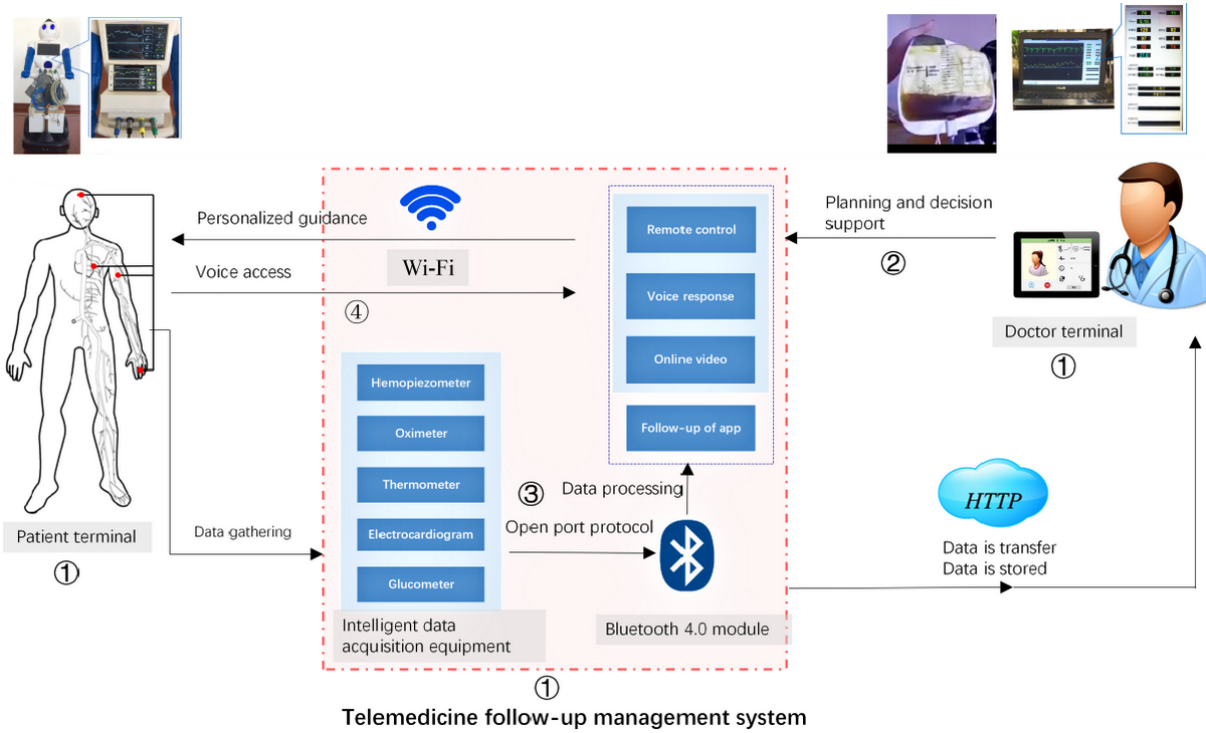
Figure 1. Schematic of the telemedicine follow-up management system. ① The telemedicine follow-up management system includes doctor-terminal, patient-terminal, and management platform. ② The transplant specialist remotely controlled the intelligent robot “face-to-face” communication with patients by a computer, mobile phone, and tablet from anywhere, such as monitoring vital signs and T tube drainage. ③ Based on Internet-based telecommunication systems, the physiological parameters, such as respiratory rate, ECG, blood pressure, oxygen saturations processed, blood sugar or authorized by transplant specialists with feedback to the patients, were telemonitored by wireless equipment. ④ The patients could communicate with the transplant specialists about the examination results through the telemedicine follow-up management system in real-time or using store-and-forward